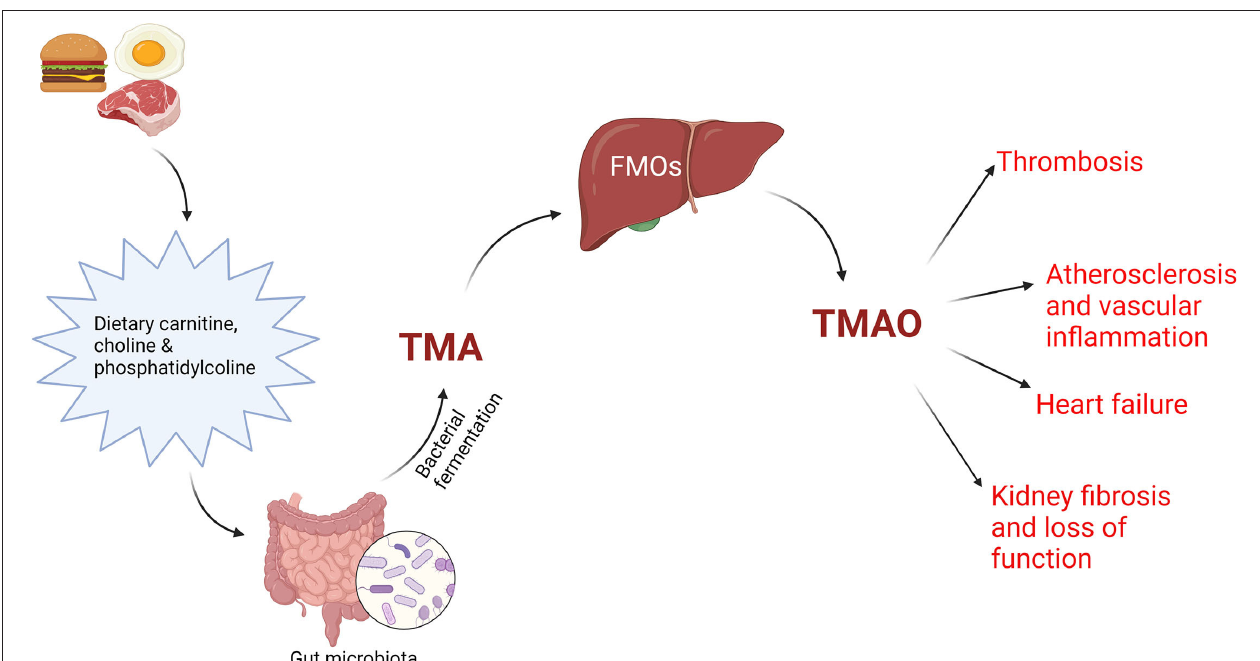
FIGURE 1 | TMAO pathway. Dietary precursors, like carnitine, choline and phosphatidylcholine are metabolized by gut microbiota into trimethylamine (TMA), which will interact with flavin monooxygenases (FMOs) in the liver, producing trimethylamine N-oxide (TMAO), an important factor in the pathogenesis of CVD. Created with BioRender.com (Last accessed on 16 January